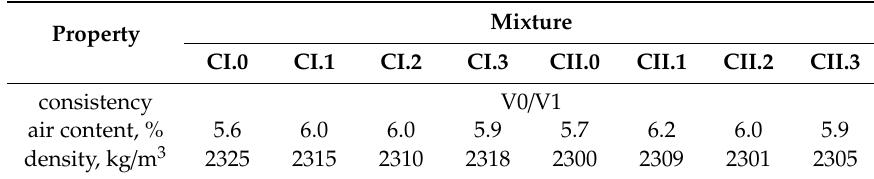
Table 8. Results obtained from concrete mixtures.